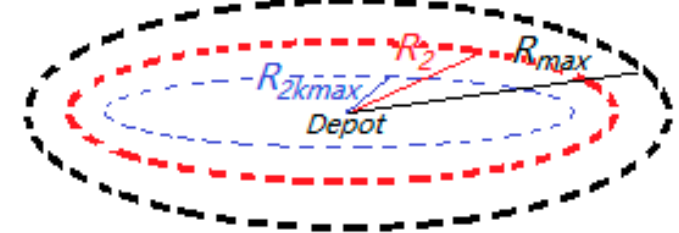
Figure 1. The scope circle for the first customer selecting.